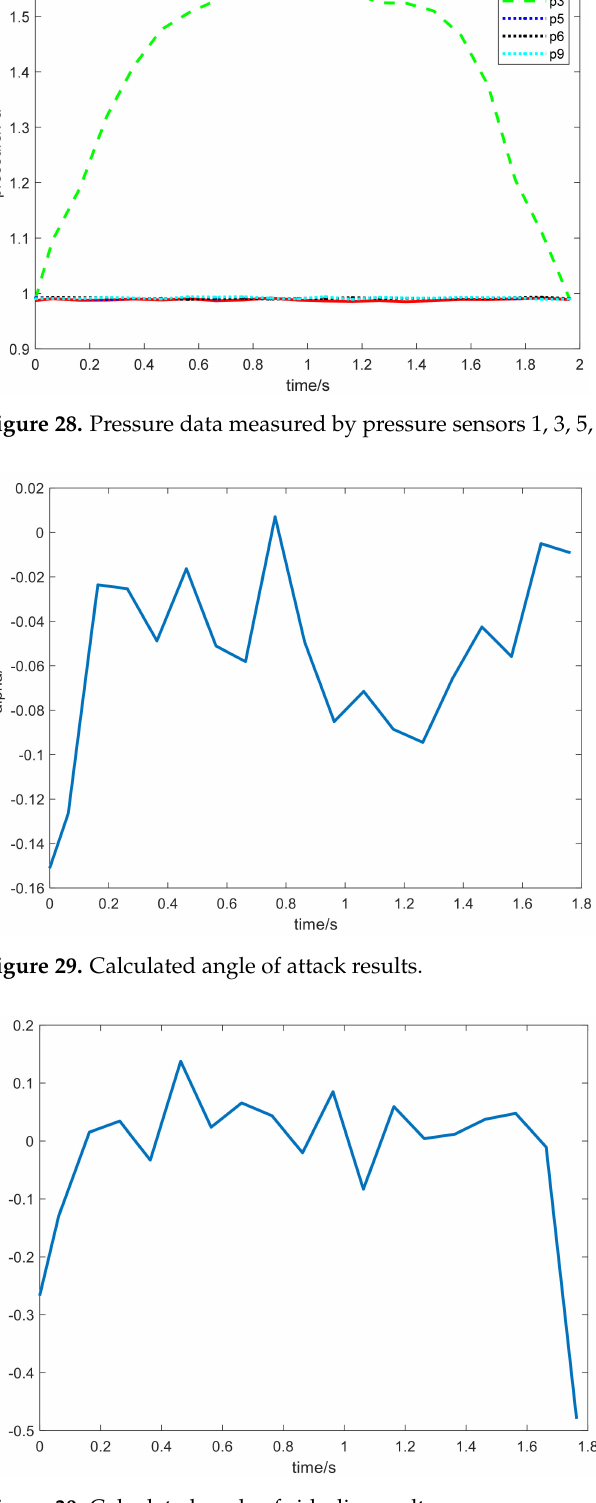
Figure 30. Calculated angle of sideslip